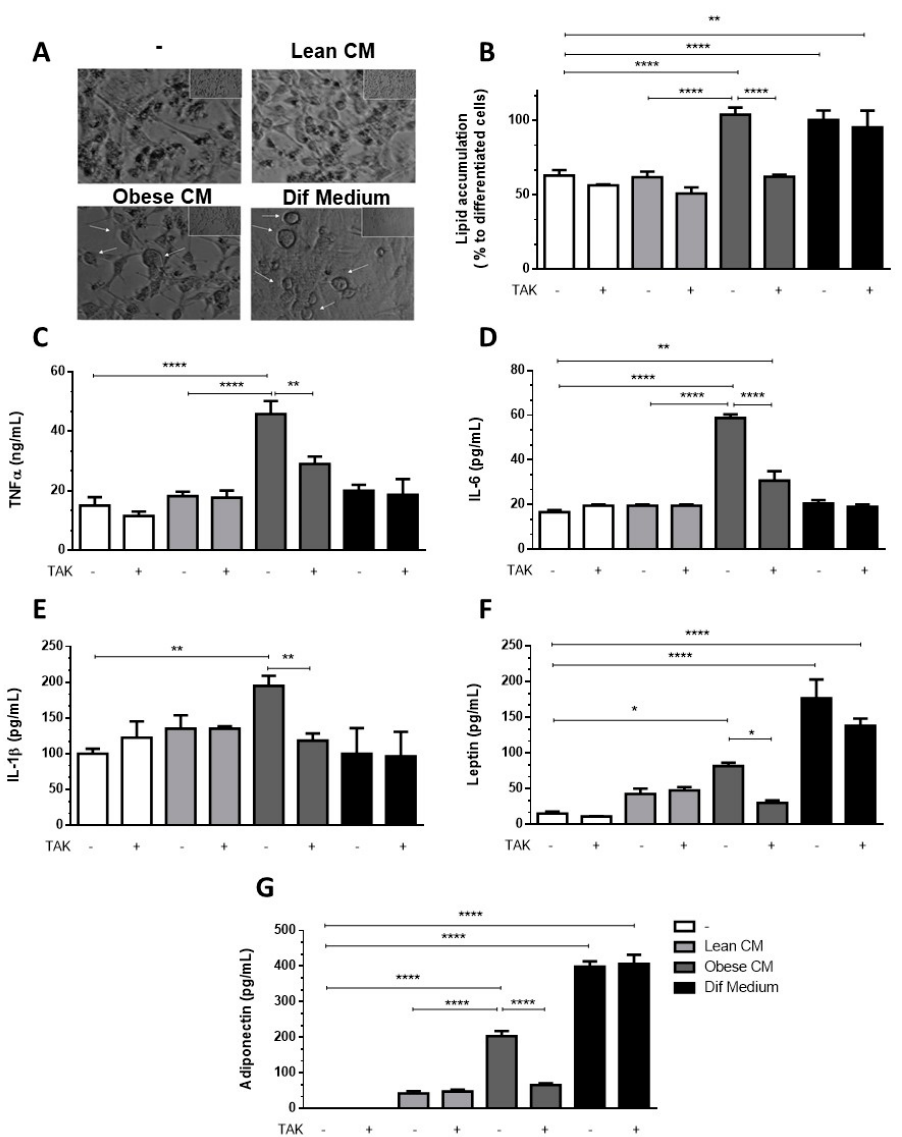
Figure 5. 3T3-L1 cells were left untreated or were pre-incubated with TAK-242 (TAK) 1 µ M for 15 min, at 37 ◦ C / 5% CO 2 . After pre-treatment, 3T3-L1 cells were treated or not with Lean Conditioned Medium (CM), Obese Conditioned Medium, or di ff erentiation mix. After seven days, the images were registered in an optical microscope ( A ) or lipid were stained with Oil red O which was quantified in a plate cell reader ( B ). D-H. After six days the medium was removed, and cells were incubated with DMEM 1% FBS, for 24 h (to complete seven days). TNF α ( C ), IL-6 ( D ), IL-1 β ( E ), leptin ( F ), and adiponectin ( G ) were measured in supernatants using a sandwich enzyme-linked immunosorbent assay kit. Results are representative of three independent experiments. B-H. Data are expressed as means ± SEM. * Represents p < 0.05, ** represents p < 0.01, **** represents p <